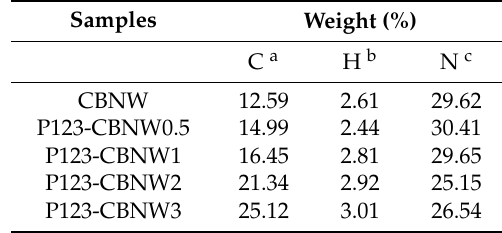
Table 1. Elemental analyses of the adsorbents fabricated.